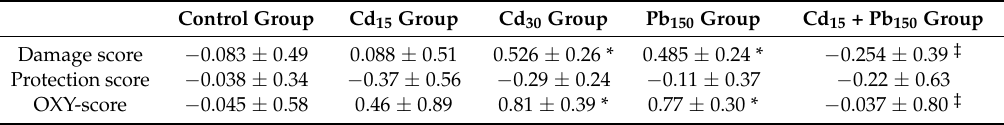
Table 4. Oxidative stress score after acute exposure to Cd or/and Pb in rats.